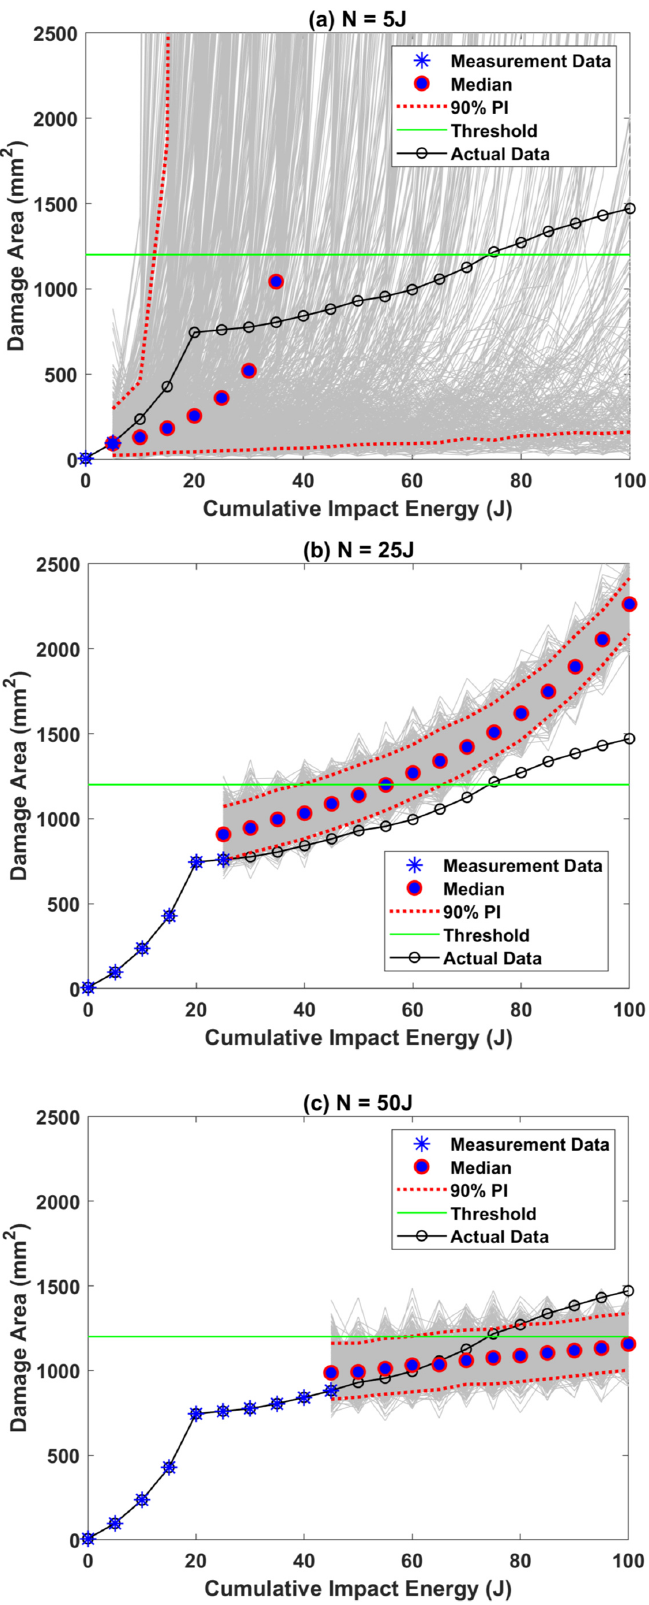
Figure 3. The prediction results for delamination 1 of sample S1 using the Paris model with failure threshold assumed to be at 1200 mm 2 . The grey lines represent the particle trajectories for 1000 particles in the particle filter framework.